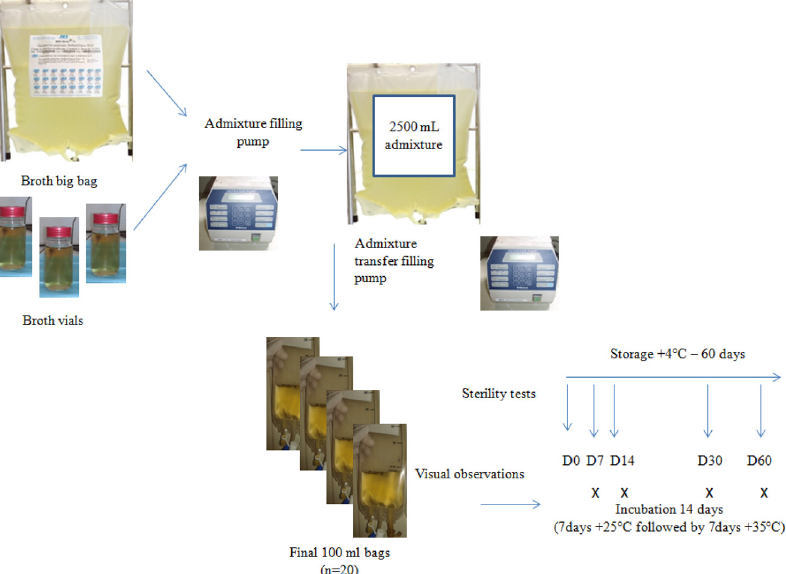
Figure 1: Process simulation method and sterility analysis per